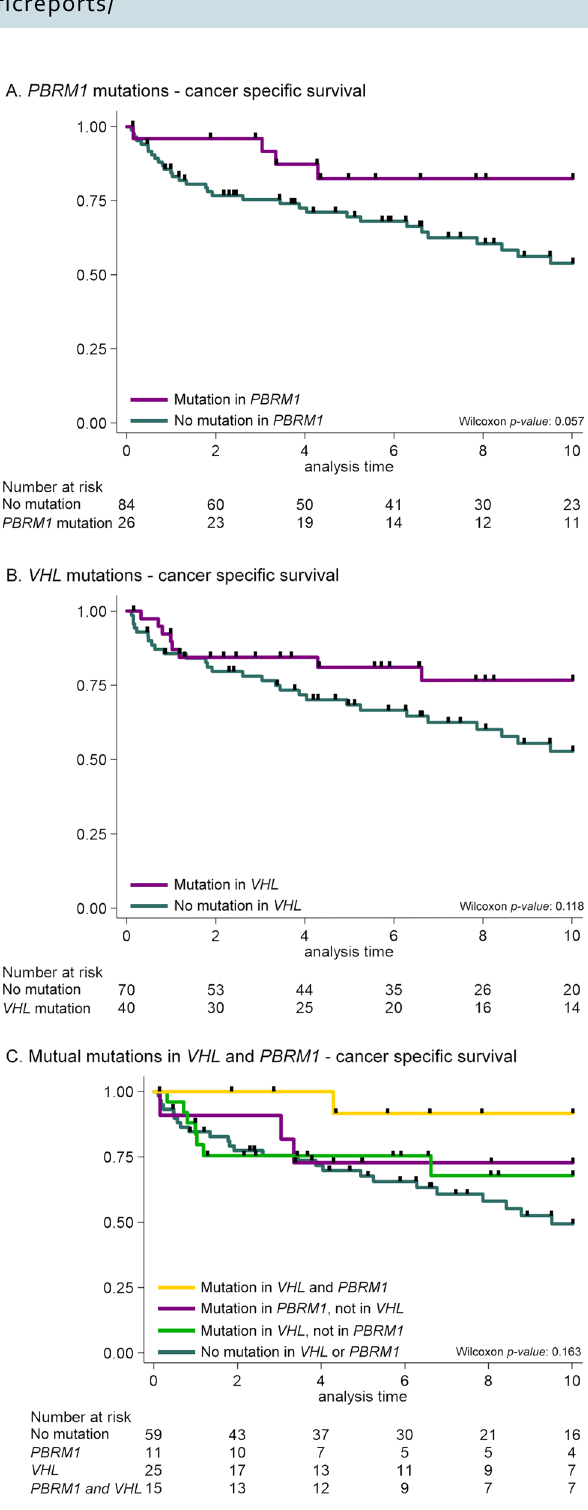
Figure 2. Kaplan–Meier curves for the associations of ( A ) PBRM1 , ( B ) VHL mutations and ( C ) mutual PBRM1 and VHL mutations with ccRCC-specific survival truncated at 10-years of